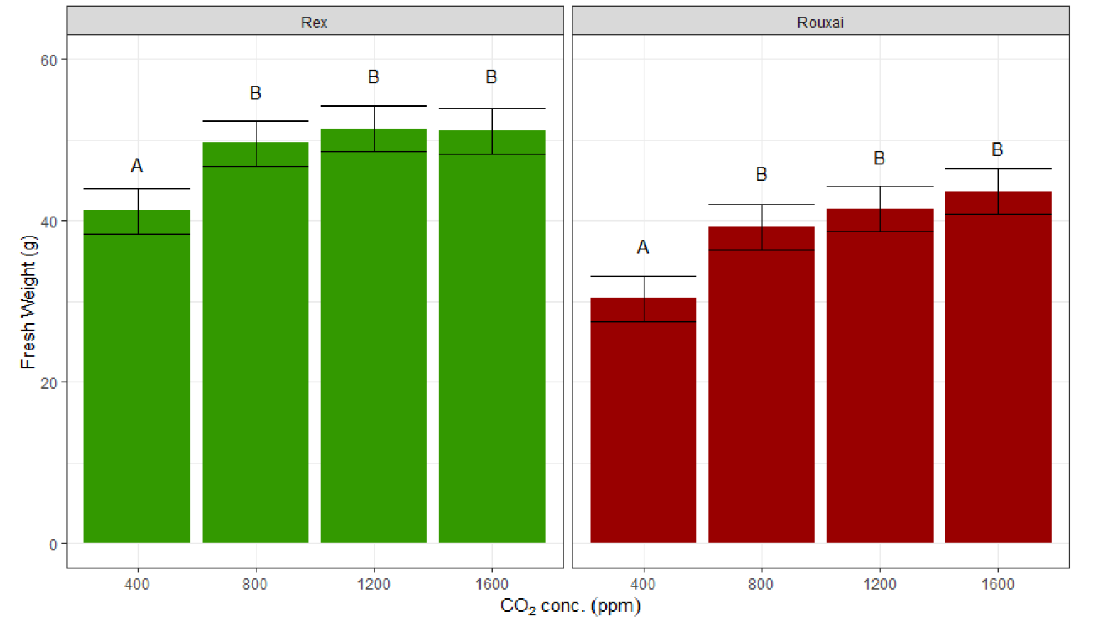
Figure 3. Fresh weight biomass of lettuce ‘Rex’ and ‘Rouxai’ after 21 days in response to CO 2 concentration. Data represent estimated marginal means and standard error as calculated by five plants per cultivar in each of four replicate crop cycles in a complete randomized block design. Letters represent mean separation comparison using Tukey’s Honestly Significant Difference (alpha = 0.05).